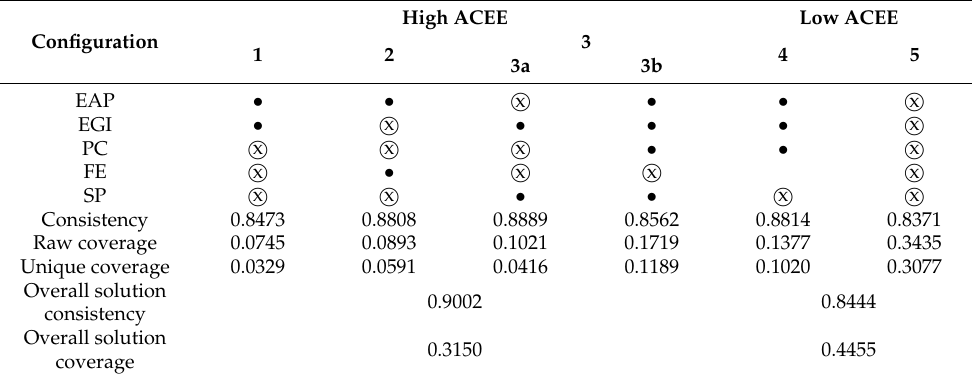
Table 7. Multi-factor combination path analysis of high ACEE and low ACEE.